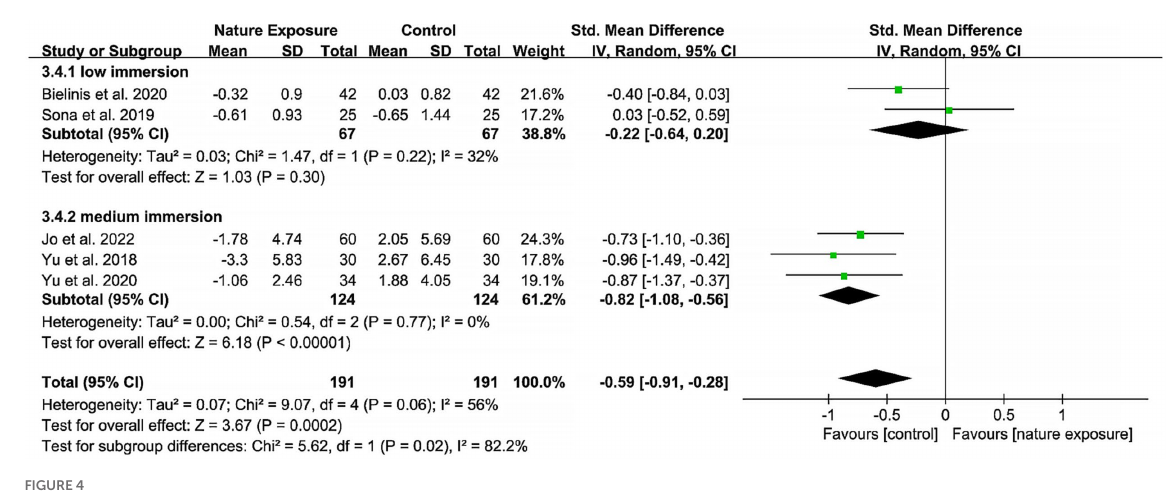
FIGURE 4 Subgroup analysis of the effects of simulated nature exposure on